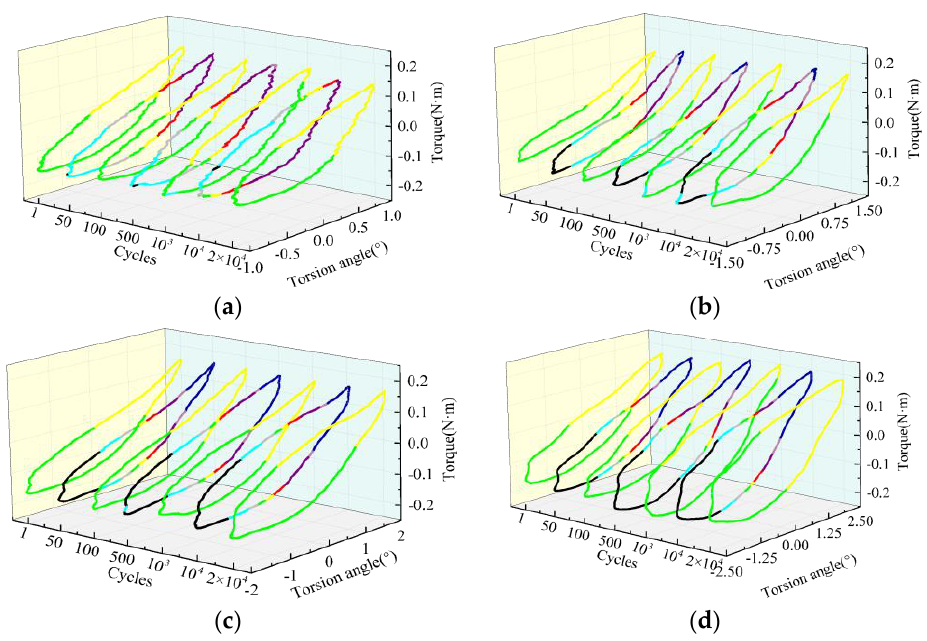
Figure 10. Evolutions and dissipation energy of torque versus torsion angle during tension–torsion cyclic loading at different torsion angles. ( a ) θ=±1°. ( b ) θ=±1.5°. ( c ) θ=±2°. ( d ) θ=±2.5°. (4)